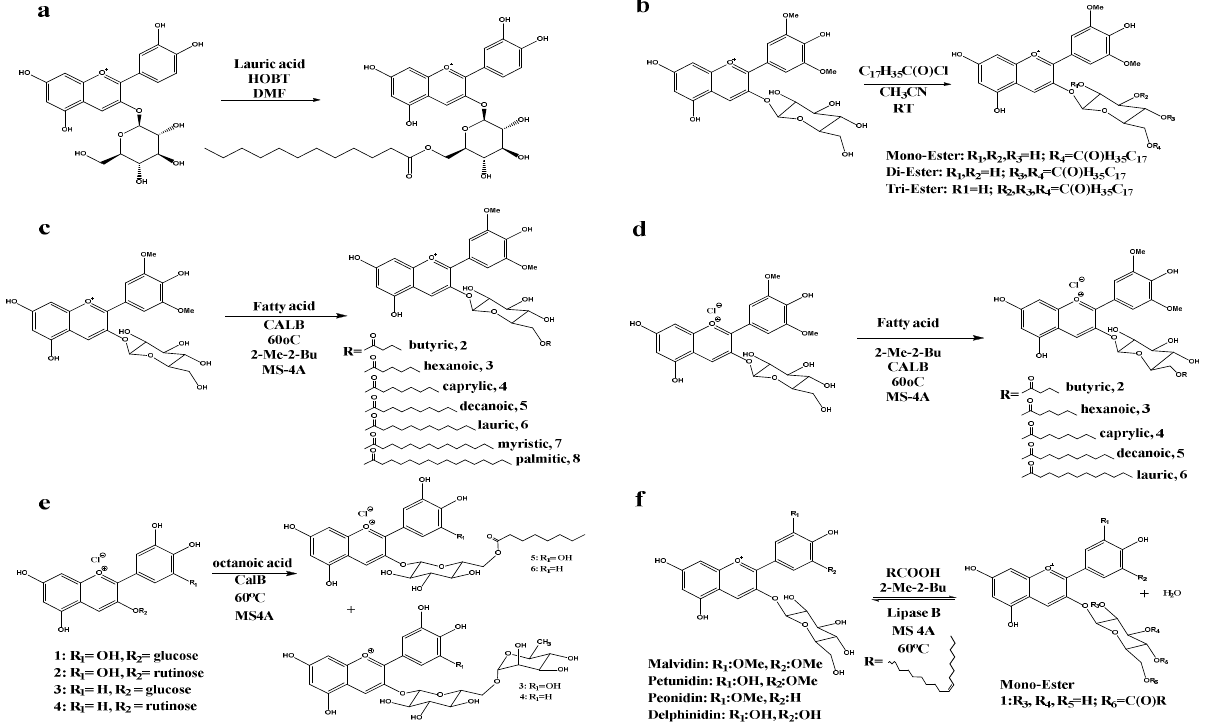
Figure 3. Examples of anthocyanin acylation. ( a ) The reaction scheme of derivatization of malvidin- 3-glucoside with stearoyl chloride [43]. Reproduced with permission from Cruz, L, Food Chem. ; published by Elsevier, 2015. ( b ) The chemical acylation between cyanidin-3-glucoside and lauric acid [40]. Reproduced with permission from Zhao, L.-y, Int. J. Food Prop. ; published by Taylor and Francis Online, 2015. ( c ) The reaction of enzymatic esterification of the malvidin-3-glucoside [9]. Re- produced with permission from Cruz, L, Food Funct. ; published by Croyal Society of Chemistry, 2016. ( d ) Enzymatic esterification reactions between malvidin 3-glucoside and different fatty acids [44]. Re- produced with permission from Cruz, L, J. Agric. Food Chem. ; published by ACS, 2017. ( e ) Enzymatic esterification reactions between anthocyanins and octanoic acid under the catalysis of CALB [45]. Reproduced with permission from Cruz, L, Food Chem. ; published by Elsevier, 2018. ( f ) Enzymatic esterification reactions between cyanidin-3-glucoside and various fatty acids [46]. Reproduced with permission from Grajeda-Iglesias, Food Chem. ; published by Elsevier,